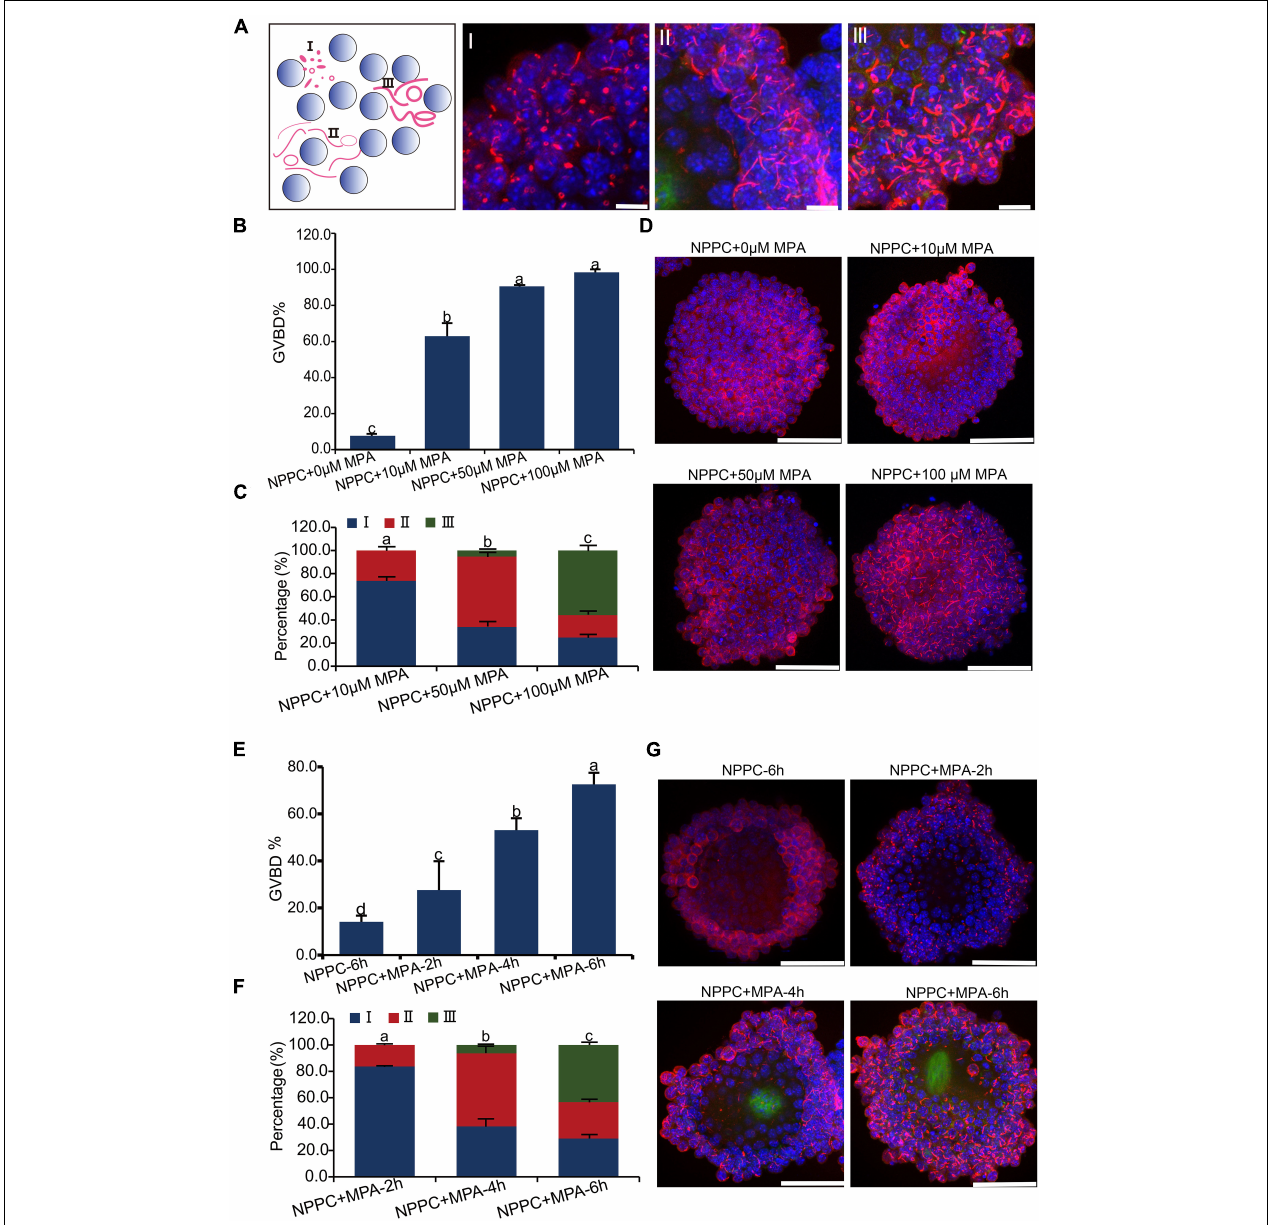
FIGURE 4 | Inhibition of IMPDH activity in COCs cultured in NPPC-supplemented medium induces reversal of oocyte meiotic arrest and aggregation of IMPDH2 into cytoophidia in cumulus cells. (A) Schematic illustration (far left panel) and representative images of the three types of IMPDH2 cytoophium classified based on the shape and size (length and thickness) of the aggregates. (B–D) Effects of treating COCs with different doses (0, 10, 50, 100 µ M) of IMPDH inhibitor MPA on oocyte meiotic resumption (B) and cumulus cell IMPDH2 aggregation (C,D) . (E,F) Effects of treating COCs with 100 µ M- MPA for different time (2, 4, 6 h) on oocyte meiotic resumption (E) and cumulus cell IMPDH2 aggregation (F,G) . COCs not treated with MPA and cultured for 6 h served as control. IMPDH2 and DNA are stained in red and blue, respectively. Scale bars: 50 µ m. Bars without letters in common are considered to be significantly different ( P <